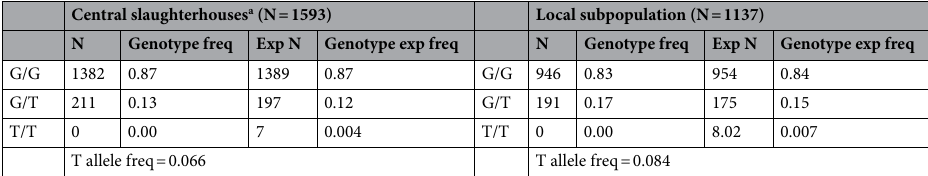
Table 5. Genotypic frequencies of AC_000174.1:g.74743512G>T in CDC45 in central slaughterhouses and a local subpopulation. a Central slaughterhouses in Tokyo Metropolitan Central Wholesale Market, Tokyo, and Nanko Wholesale Market, Osaka.